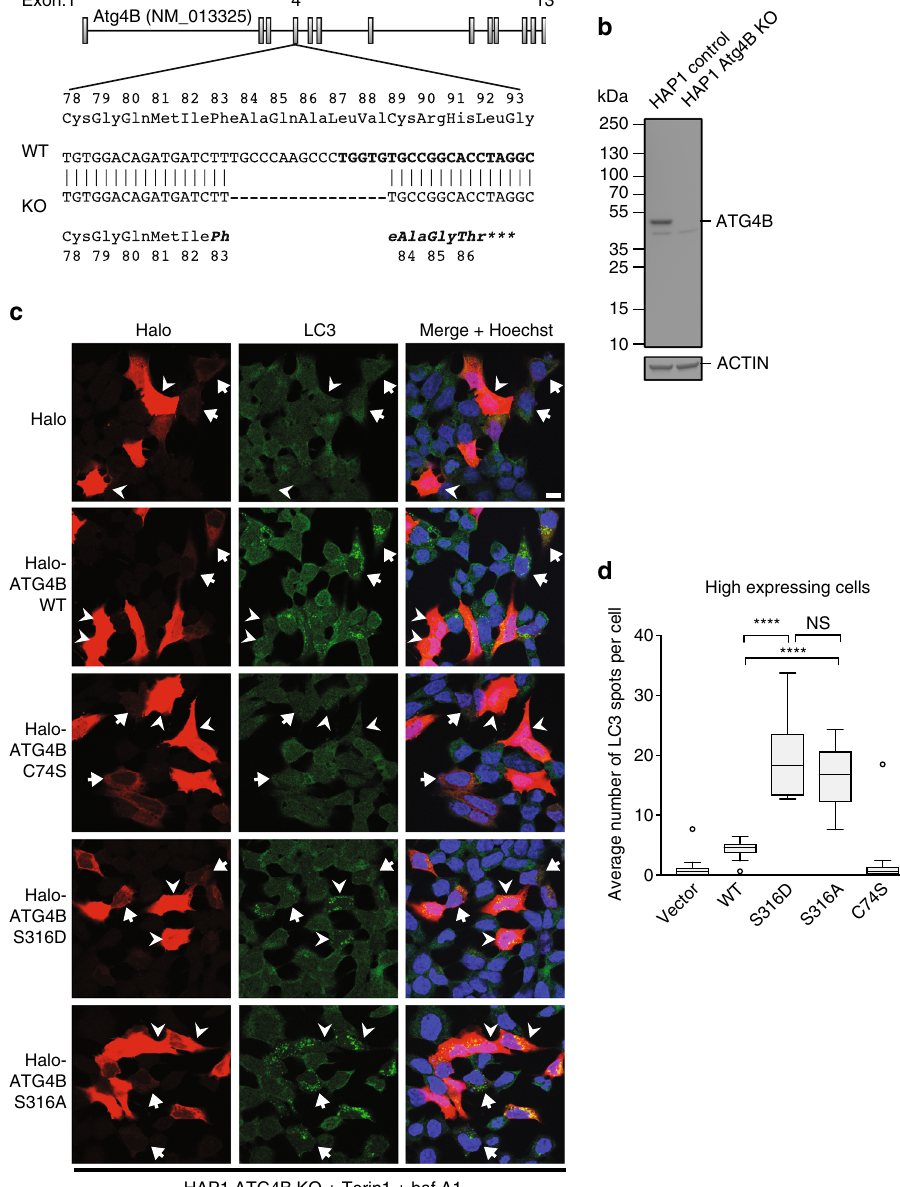
Fig. 4 Quanti fi cation of LC3-positive autophagosomes in ATG4B knockout cells rescued with the phosphomimetic ATG4B S316D mutant. a Validation of CRISPR-mediated modi fi cation to the genomic locus of ATG4B exon 4 in the HAP1 ATG4B KO cell line. The gene structure of the WT human ATG4B locus on chromosome 2 is shown, and the region in exon 4 targeted for modi fi cation is revealed at the sequence level. The DNA sequence targeted by the custom sgRNA is shown in bold. The 16 bp deletion in the ATG4B KO clone results in a frameshift and early stop codon, as shown by the DNA sequence alignment. b Protein-level validation of ATG4B knockout. Lysates from untreated HAP1 control and ATG4B KO cells were run on a 4 – 20% polyacrylamide gel and immunoblotted with antibodies against ATG4B and beta-actin. The ATG4B KO cells showed a total absence of the speci fi c band representing ATG4B. c ATG4B KO HAP1 cells were transfected with the indicated Halo constructs. After 24 h, cells were simultaneously stained live with a Halo ligand dye and treated with 250 nM Torin1 and 10 nM ba fi lomycin A1 for 3 h, prior to fi xation and staining for endogenous LC3. Arrowheads indicate high Halo construct-expressing cells, and arrows indicate cells expressing low levels of these constructs. Scale bar 10 µ m. d Quanti fi cation of the average number of autophagosome per cell in the high expressing cells is shown (Tukey ’ s plot, n = 10 fi elds, with an average of 5 quanti fi ed cells per fi eld). **** p < 0.0001, NS not signi fi cant (Sidak ’ s multiple comparison